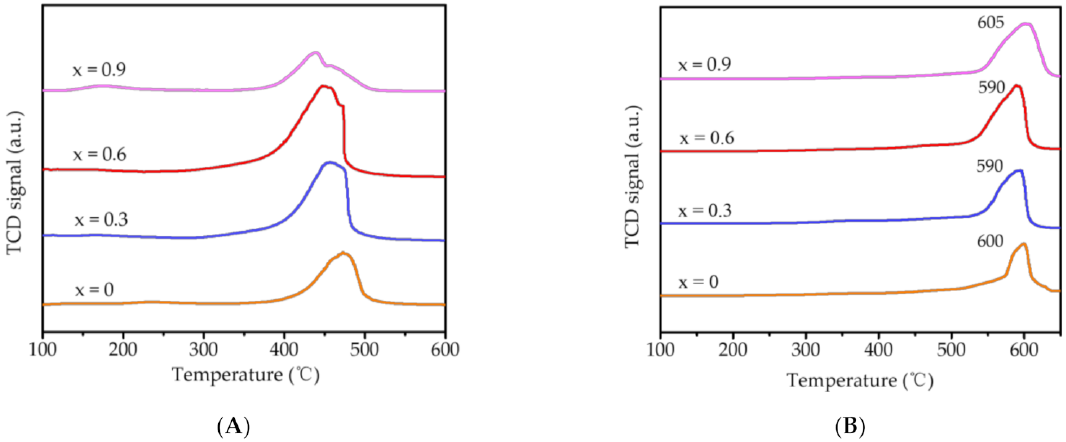
Figure 6. ( A ) NH 3 -TPD curves and ( B ) H 2 -TPR curves of samples with different x values